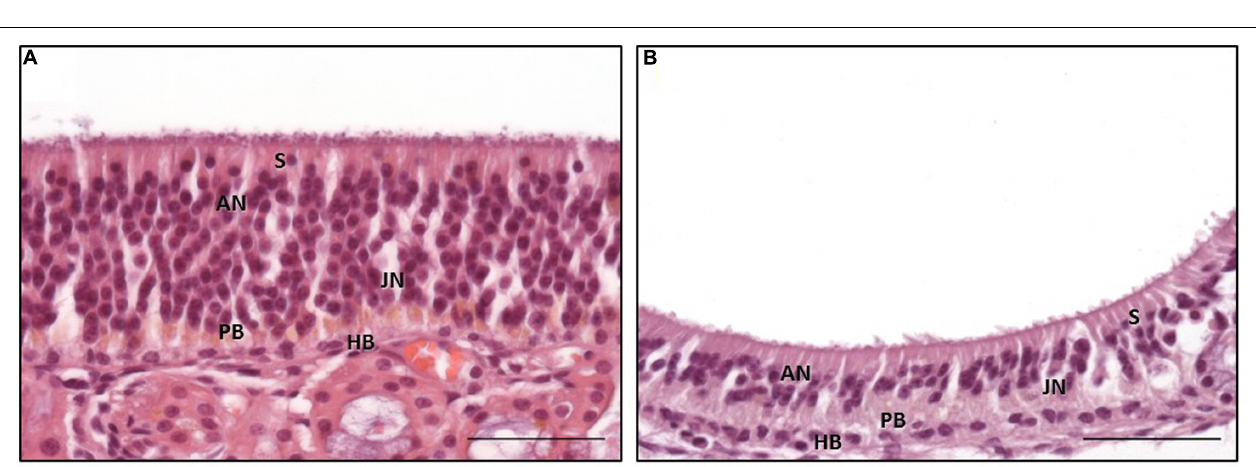
FIGURE 2 | Percentage of the olfactory epithelium (OE) of the whole epithelium in five equine noses for all sections containing OE (A–D), split up for localizations 1–5; (1) nasal septum, (2) dorsal, (3) mid, (4) ventral part of the nasal turbinates, (5) lining of the nasal cavity; bar: median.